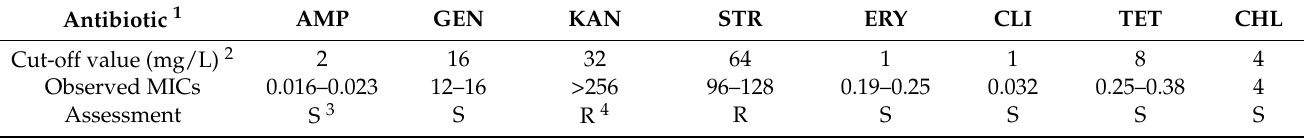
Table 4. Minimal inhibitory concentrations (MICs) of L. fermentum